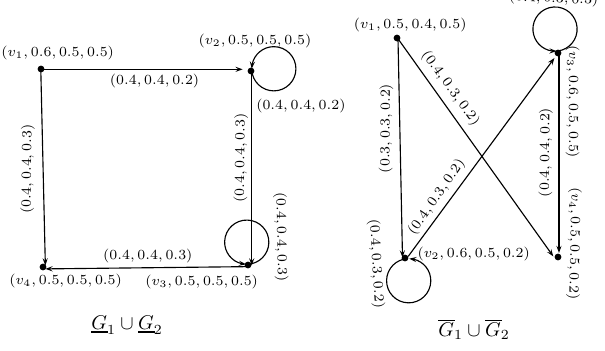
Figure 4: Neutrosophic soft rough graph G 1